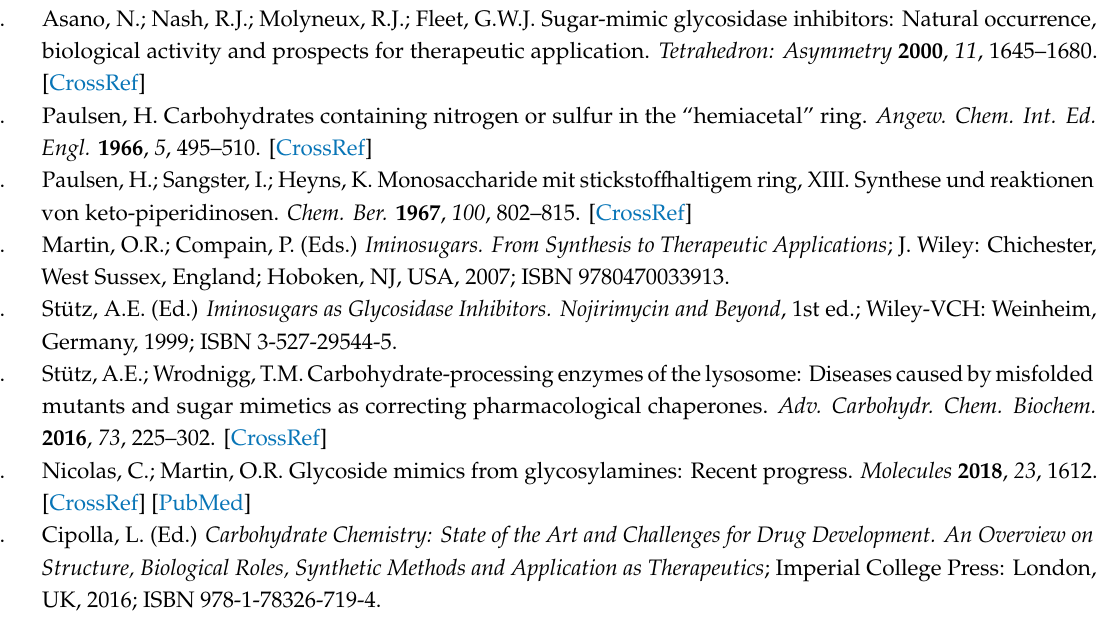
Supplementary Materials: The following are available online, NMR spectra for new compounds. Figure S1: Structure of compound 35 confirmed by XRD analysis (CCDC